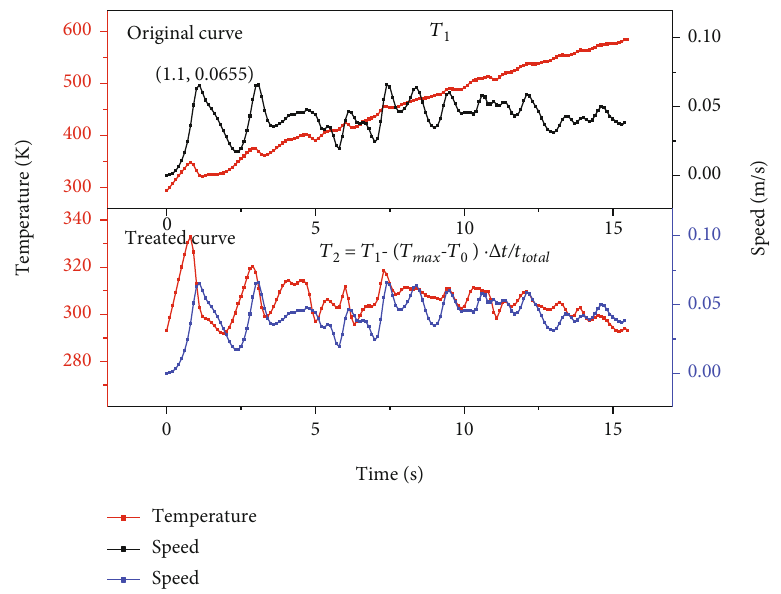
Figure 9: T - v curve at the geometric center point of the heat source domain of group O.